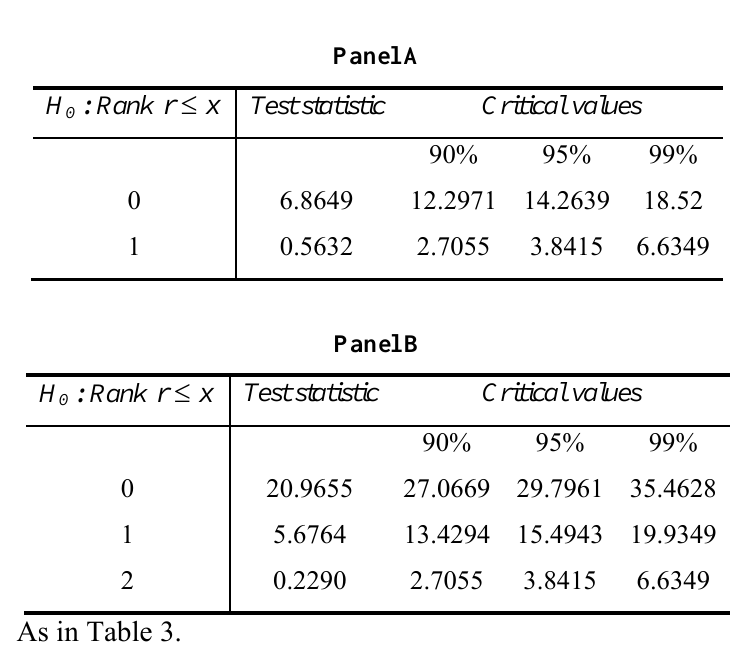
Table 4 Cointegration Tests for S&P (without consumption data)